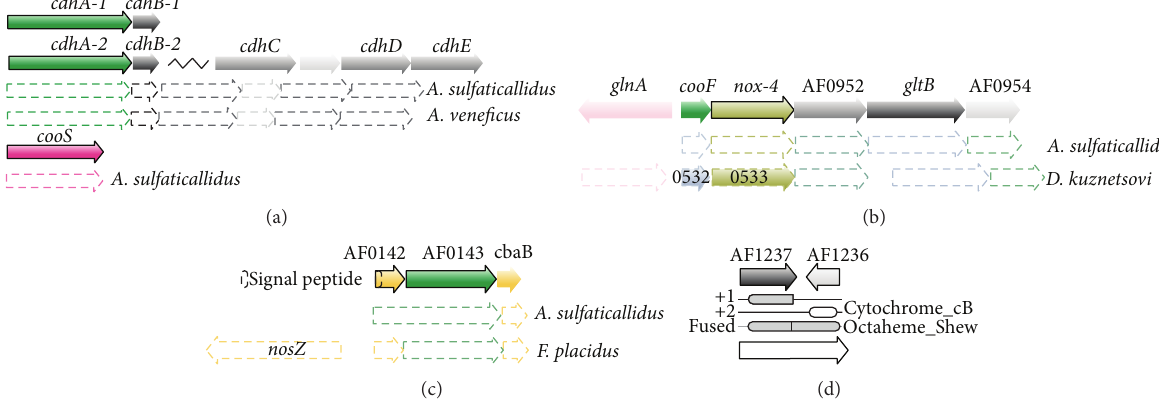
Figure 3: Homology and synteny of key genes: (a) genes of carbon monoxide dehydrogenase (CODH) and (b) the genes encoding CooF and associated NADH oxidase (nox-4). (c) genes of a putative nitrate reductase-like respiratory complex (AF0142–AF0144) and (d) the reading frame shift and encoded domains corresponding to a complete sequence of putative cytochrome